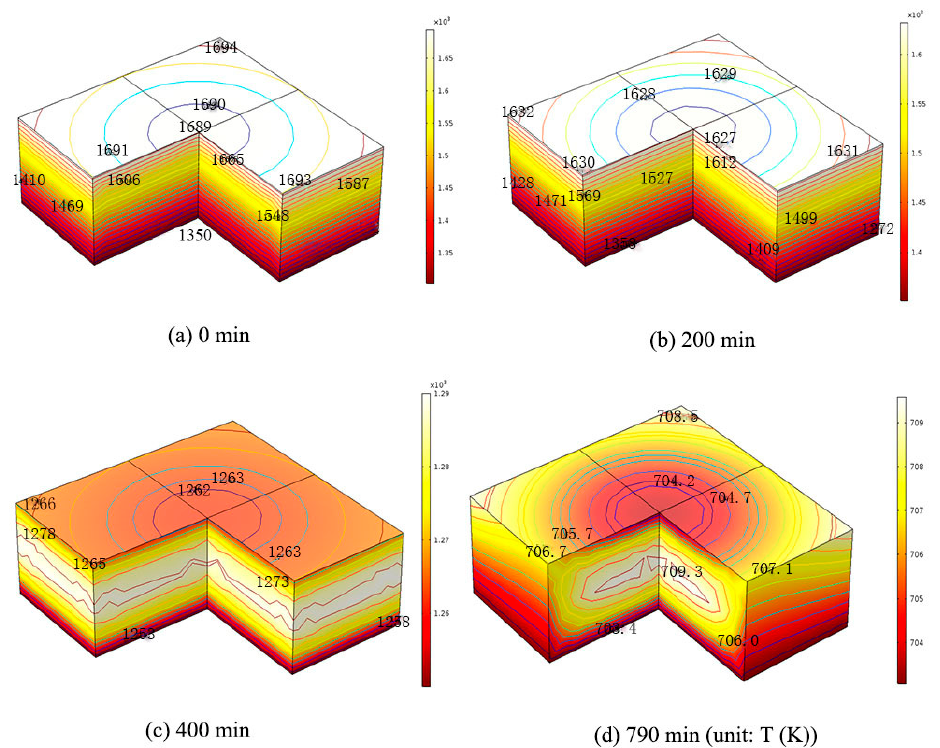
Figure 3. Temperature distribution of 0.84 m × 0.84 m × 0.3 m silicon ingot at ( a ) beginning (0 min), ( b ) 200 min, ( c ) 400 min, and ( d ) end of the modified cooling process (790 min).